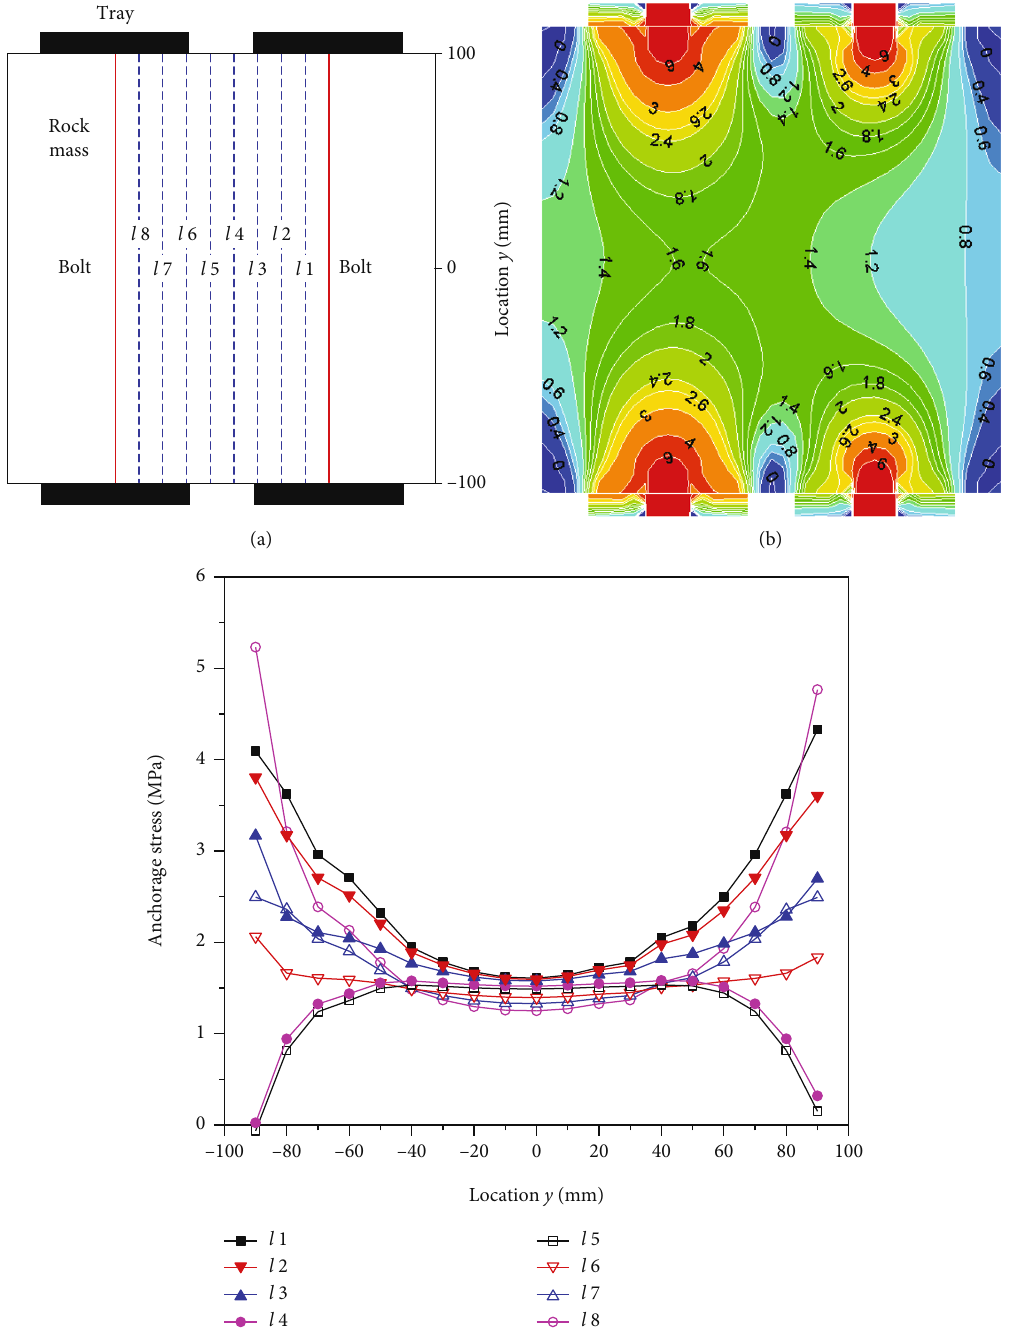
Figure 11: (a) Interested section and line, (b) anchorage stress distribution of interested section of rock mass specimen with two bolts reinforced, and (c) anchorage stress distribution in the interested